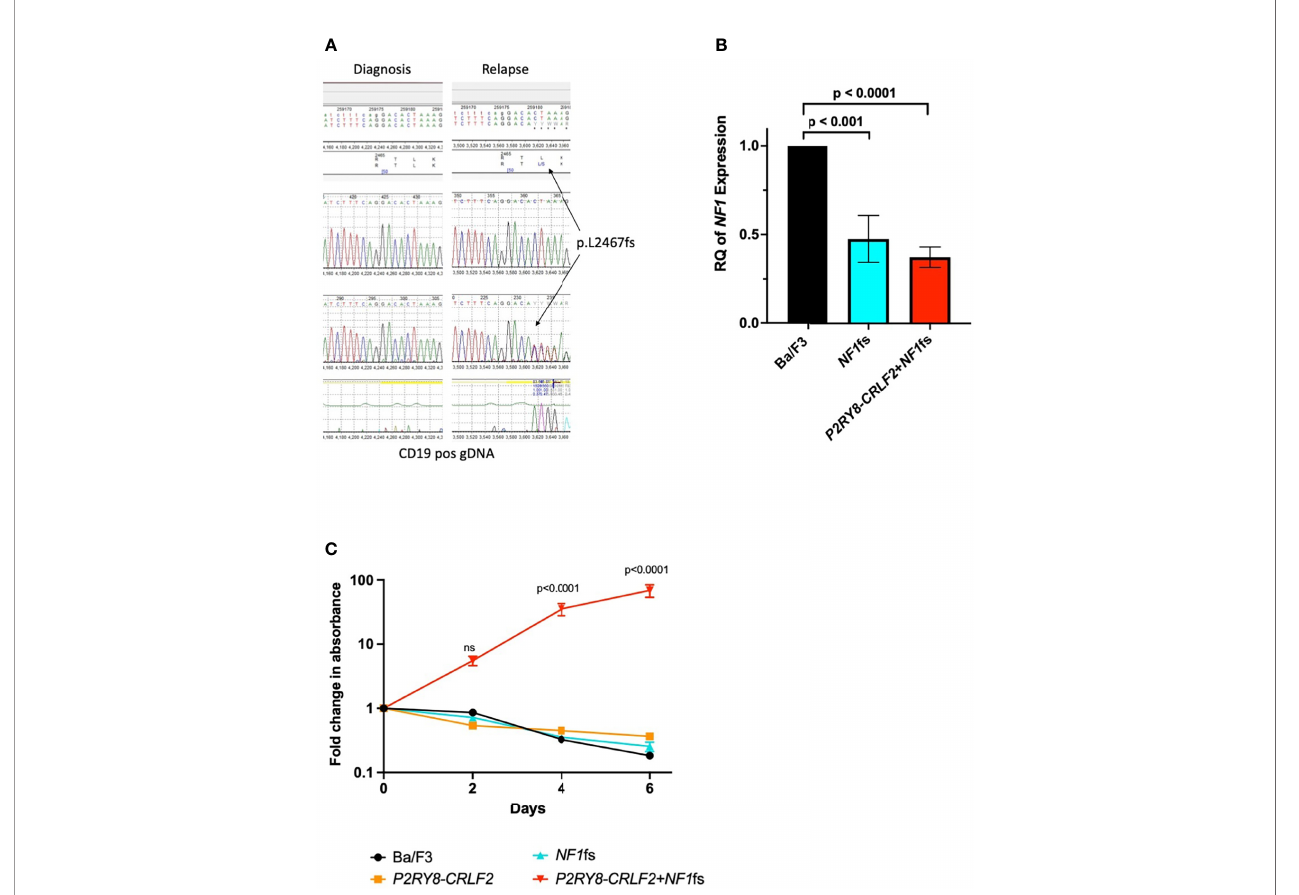
FIGURE 1 | NF1 p.L2467fs is transformative in Ba/F3 cells with the P2RY8 – CRLF2 gene fusion. (A) Sanger sequencing demonstrating the NF1 p.L2467fs occurs only at relapse in the genomic DNA of the patient. (B) qPCR con fi rming reduced expression of NF1 in of Ba/F3 cell lines containing the NF1 fs — blue and P2RY8 – CRLF2 + NF1 fs — red. RQ, relative quantitation = 2-ddCT, where Ba/F3 (black) was normalized to 1 and each cell line was compared to this control. An unpaired, 2- tailed t-test was used for statistical analysis. (C) A proliferation assay demonstrating P2RY8 – CRLF2 + NF1 fs cells (shown in red) are IL3 independent in comparison to Ba/F3 (black), P2RY8 – CRLF2 (orange) NF1 fs (blue). Results are from three independent experiments and error bars represent ± SEM, two-way ANOVA (Bonferroni multiplecomparisons) was usedfor statisticalanalysis. Allstatisticalanalyses were performed inGraphPadPrism v9, where p <0.05 was considered signi fi cant. Error bars represent ± SEM ofthree independent experiments. ns, not signi fi